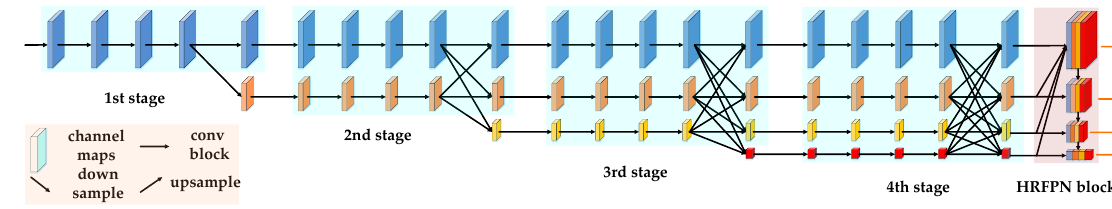
Figure 4. The architecture of the HRFPN.